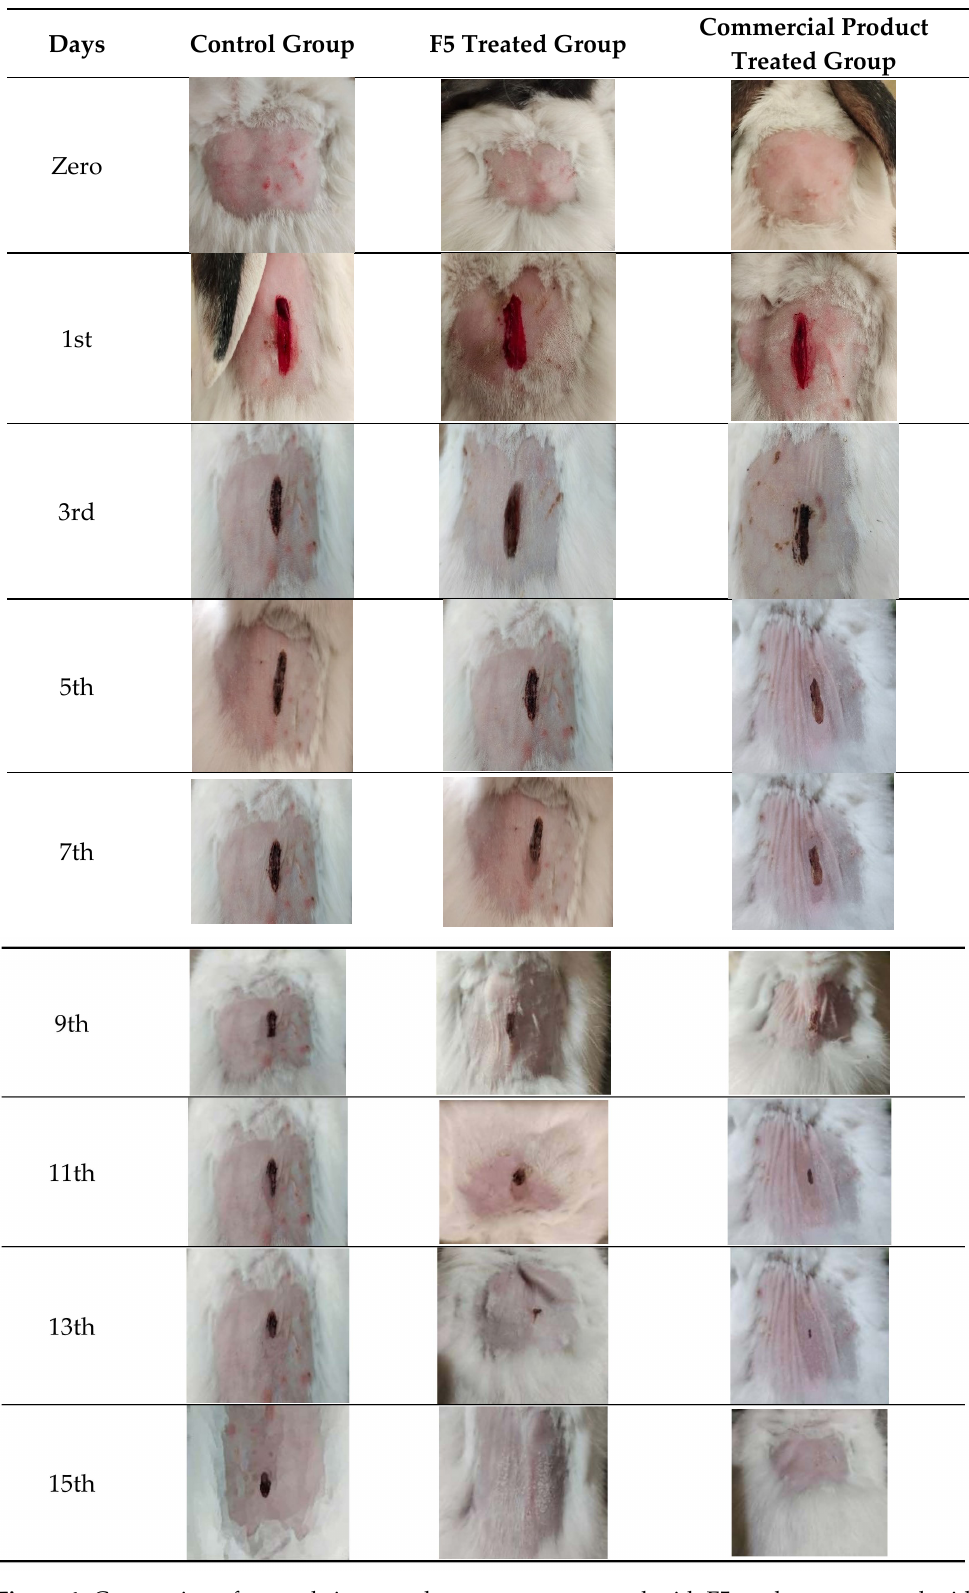
Figure 4. Contraction of wounds in control group, group treated with F5, and group treated with commercial